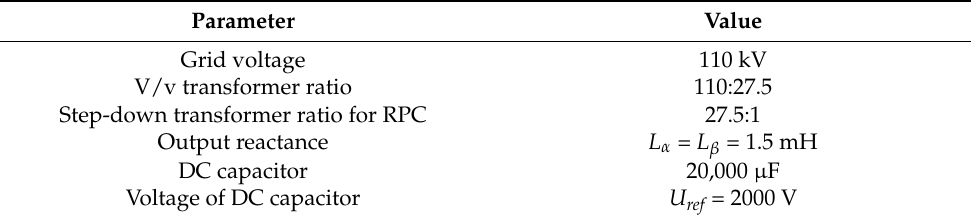
Table 4. Simulation parameters of the system.